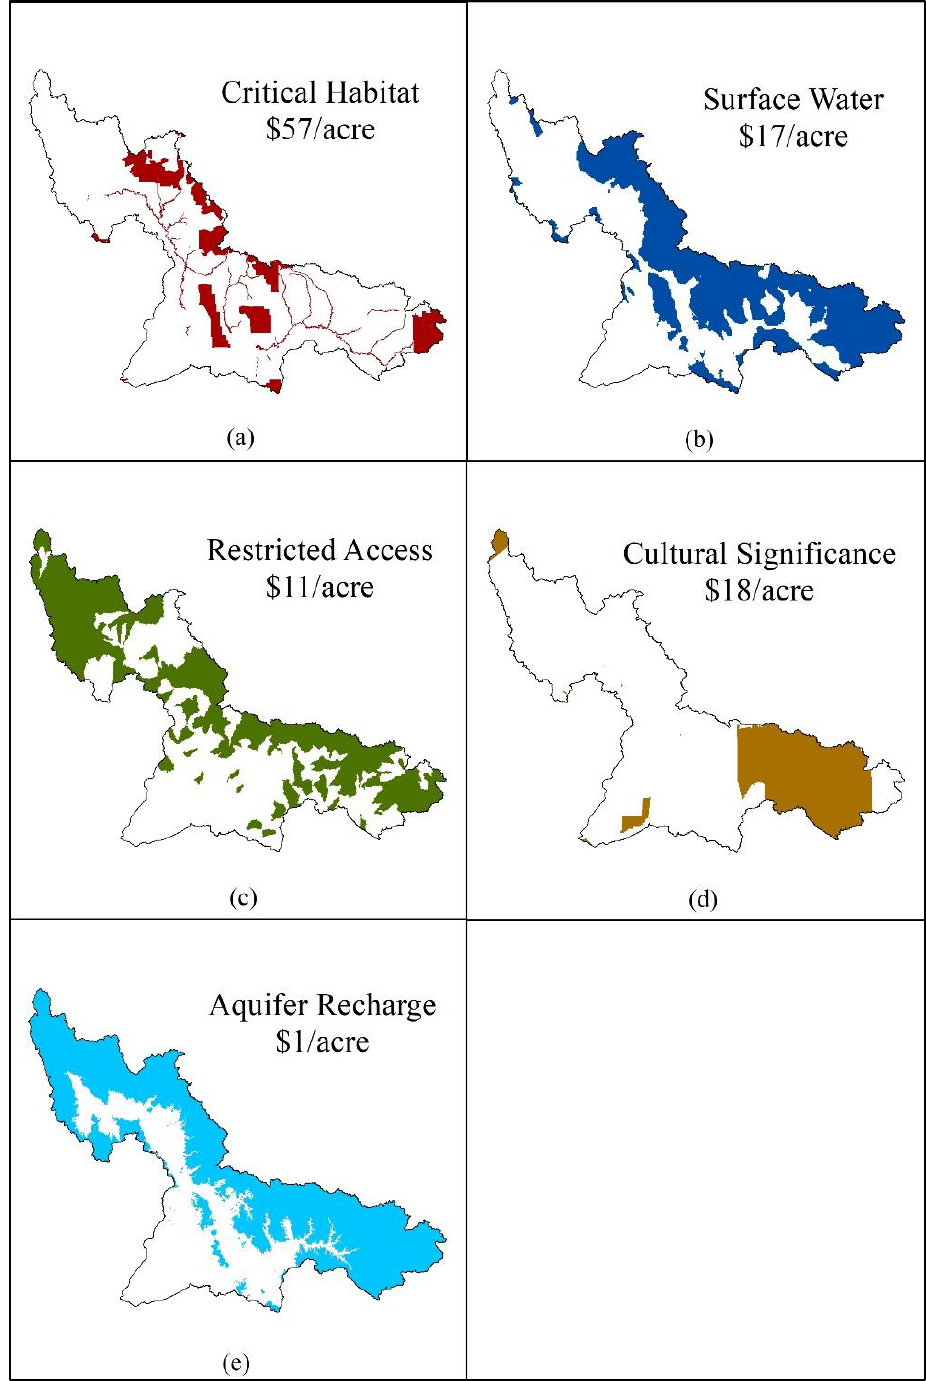
Figure 2. Map layers representing each benefit value used in spatial analysis. ( a ) Area designated as critical habitat is valued at $57 per acre. ( b ) Land that is vital to quality of surface water resources is valued at $17 per acre. ( c ) Land that is prone to forest closures due to wildland fire risk is valued at $11 per acre. ( d ) Area considered culturally significant is valued at $18 per acre. ( e ) Area contrib- uting to aquifer recharge is valued at $1 per acre. Map layers were created using the North American 1983 Datum, GCS North American 1983, Transverse Mercator projection, and NAD 1983 State Plane Arizona Central FIPS 0202 coordinate system.